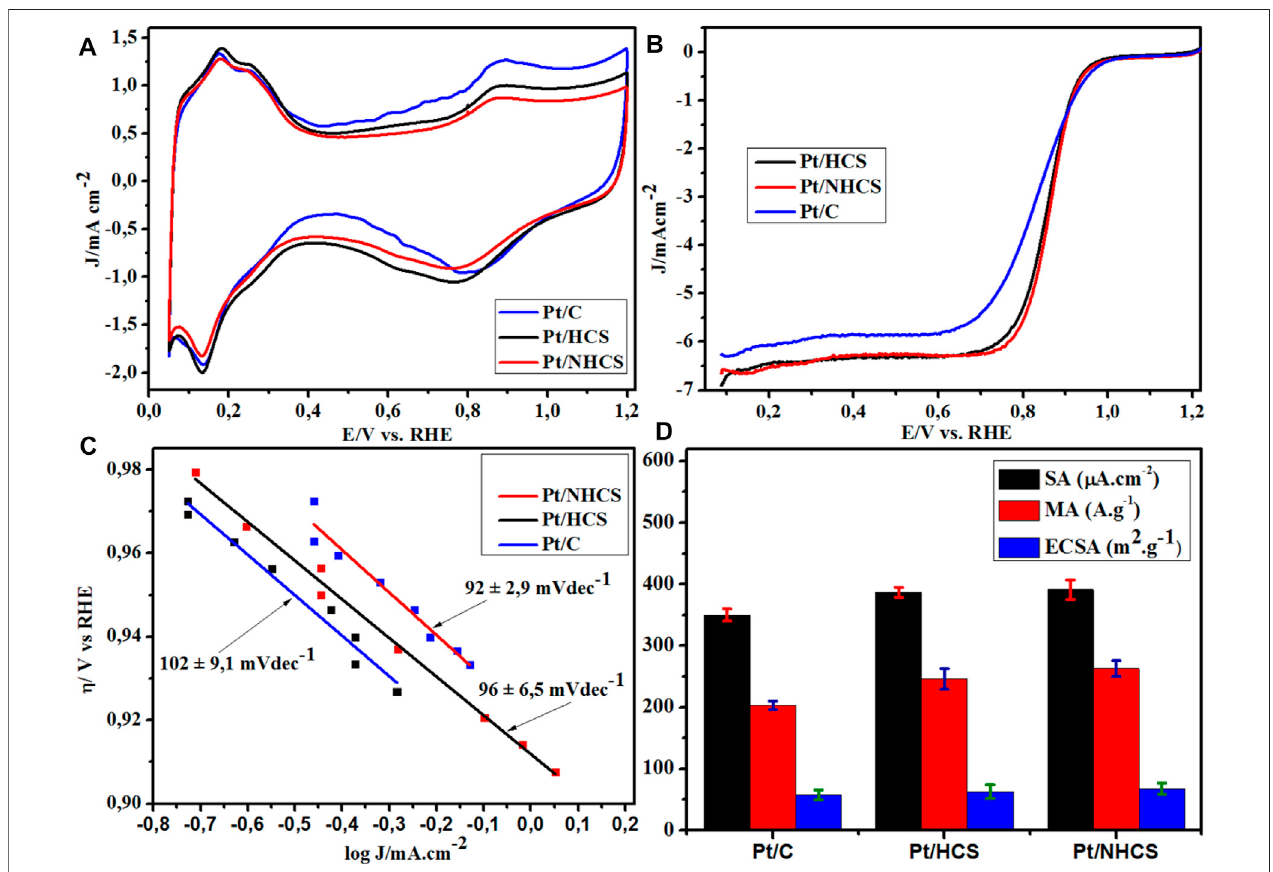
FIGURE6| The (A) cyclicvoltammograms, (B) ORRpolarizationI-Vcurves, (C) Tafelplotsand (D) ORRactivityandECSAdataforthePt/HCSs,Pt/NHCSsandthe commercial benchmark Pt/C.